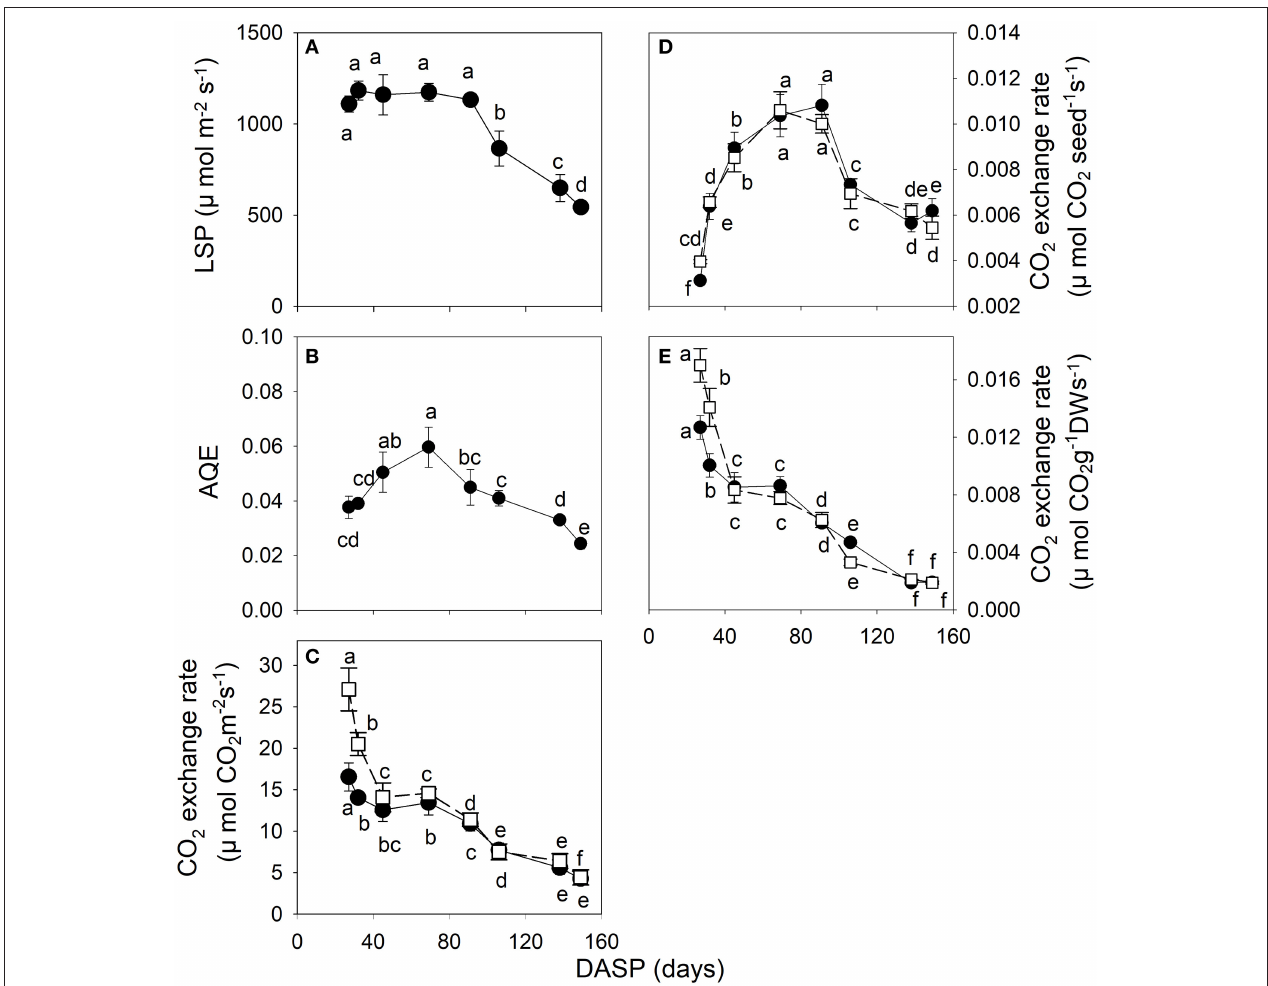
FIGURE 4 | CO 2 exchange parameters in seeds of Torreya grandis cv. “Merrillii” during seed development in 2015. The light saturation point LSP (A) , the apparent quantum use efficiency AQE (B) , the rate of CO 2 exchange on surface area (C) , single seed (D) and dry weight (E) basis. In the rate of CO 2 exchange (C–E) , both the maximal rate of gross photosynthesis at light saturation ( P ( g,max ), filled circles) and respiration rate ( R d , open squares) are indicated. For each quantity the mean ± SD is indicated. Different letters denote significant differences at P ≤ 0.05 level. n = 4 trees. DASP, days after seed